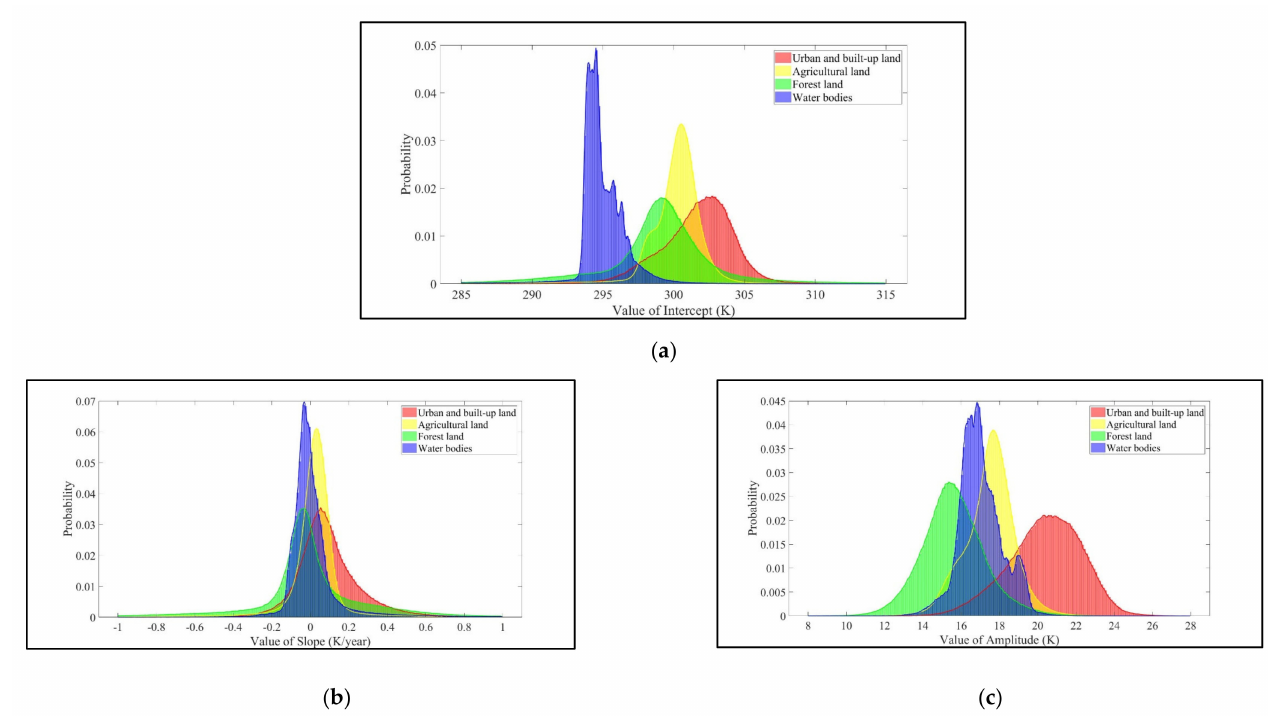
Figure 17. Distribution of normalized histogram distribution of harmonic term for four different LULC types: ( a ) intercept term, ( b ) slope term, and ( c ) amplitude